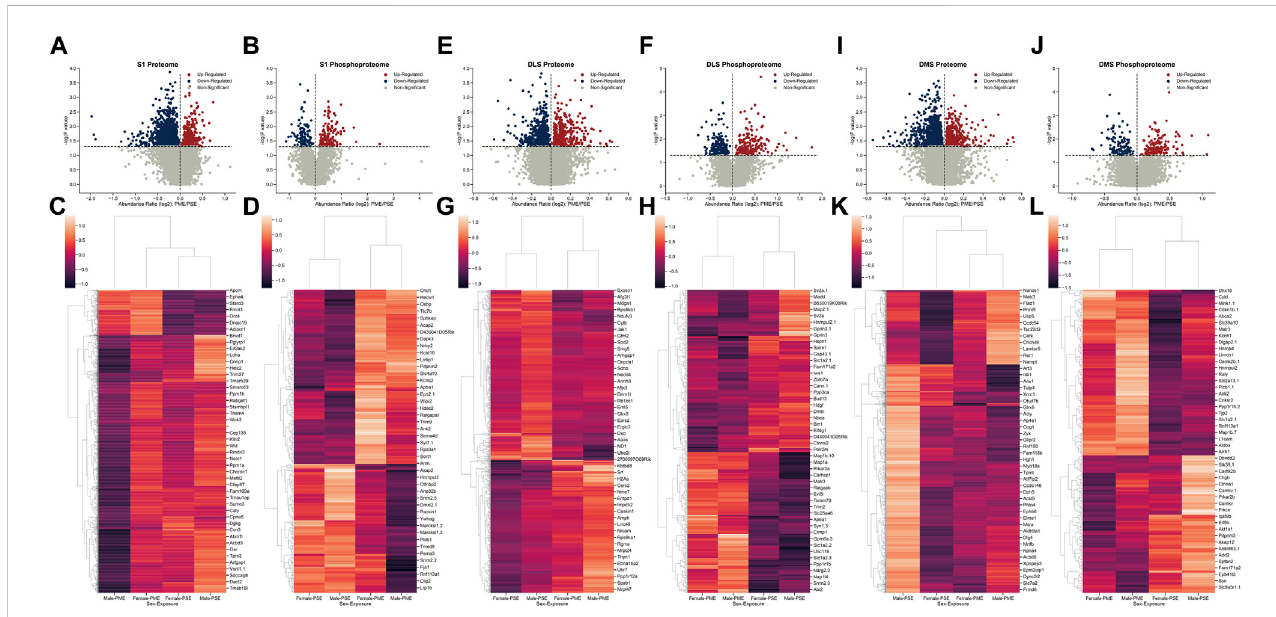
FIGURE 6 Differential protein and phosphopeptide expression in the primary somatosensory cortex (S1), dorsolateral striatum (DLS), and dorsomedial striatum (DMS) of prenatal methadone exposed offspring. Volcano plots for the differential S1 proteome (A) and phosphoproteome (B) with blue circles representing individual proteins/phosphopeptides decreased in PME vs. PSE and red circles representing individual proteins/phosphopeptides increased in PME vs. PSE which reach the level of signi fi cance. Clusterplots of differentially abundant S1 proteins (C) and phosphopeptides (D) with example GeneIDs. Volcano plotsforthedifferentialDLSproteome (E) andphosphoproteome (F) withbluecirclesrepresentingindividualproteins/phosphopeptidesdecreasedinPMEvs. PSE and red circles representing individual proteins/phosphopeptides increased in PME vs. PSE which reach the level of signi fi cance. Clusterplots of differentially abundant DLS proteins (G) and phosphopeptides (H) with example GeneIDs. Volcano plots for the differential DMS proteome (I) and phosphoproteome (J) with blue circles representing individual proteins/phosphopeptides decreased in PME vs. PSE and red circles representing individual proteins/phosphopeptides increased in PME vs. PSE which reach the level of signi fi cance. Clusterplots of differentially abundant DMS proteins (K) and phosphopeptides (L) with example GeneIDs (n = 8 (4M:4 F) PME, 8 PSE (4M:4